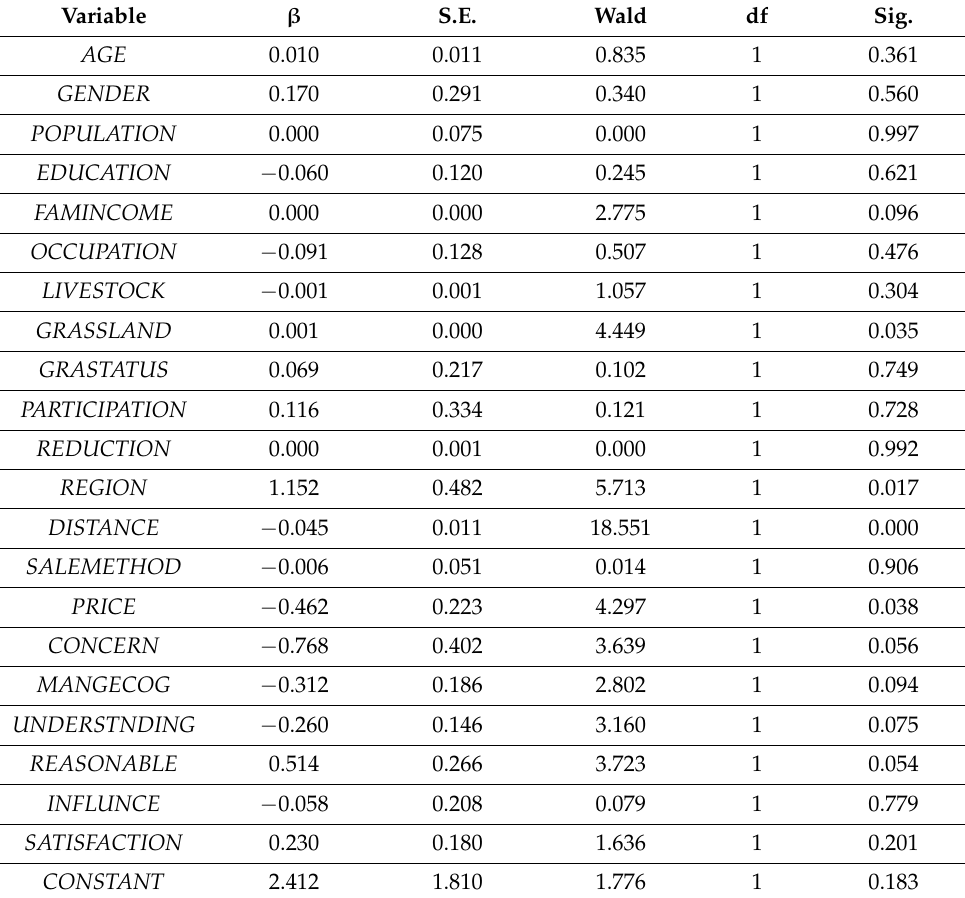
Table 3. The overall model regression